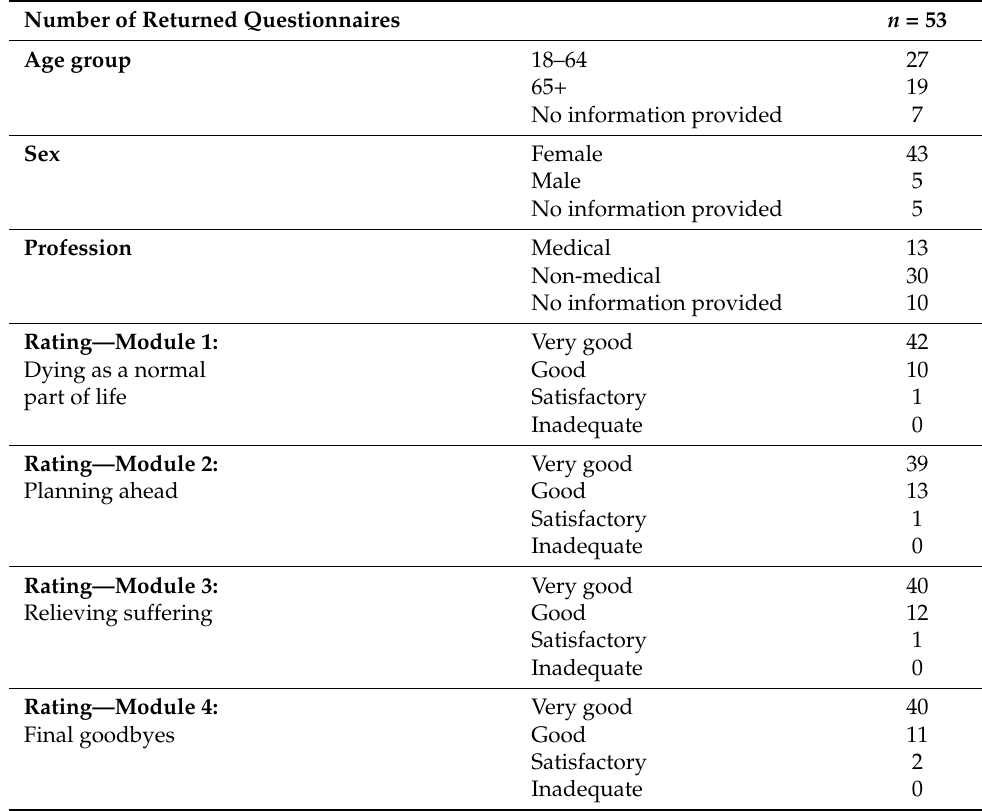
Table 2. Data from the participants and participants’ ranking of the Last Aid course content from the questionnaire ( n =